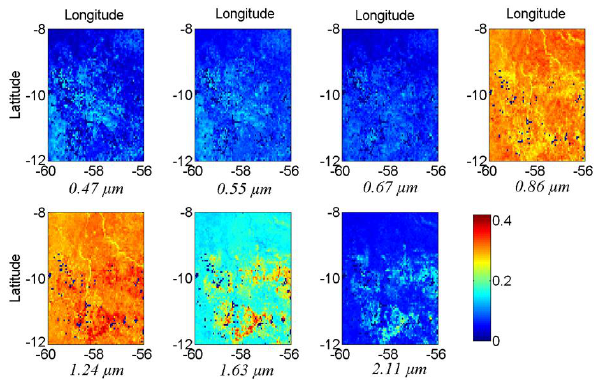
Fig. 1. Black sky albedo maps at MODIS bands 1–7 calculated from the MODIS file MCD43C1.A2006241.005.2008109074010.hdf with SZA equaling 32 degrees. The studied area is over Amazo- nian in Latitude=[ − 12 to − 8] and Longitude=[ − 60 to − 56] on Julian day 241 in